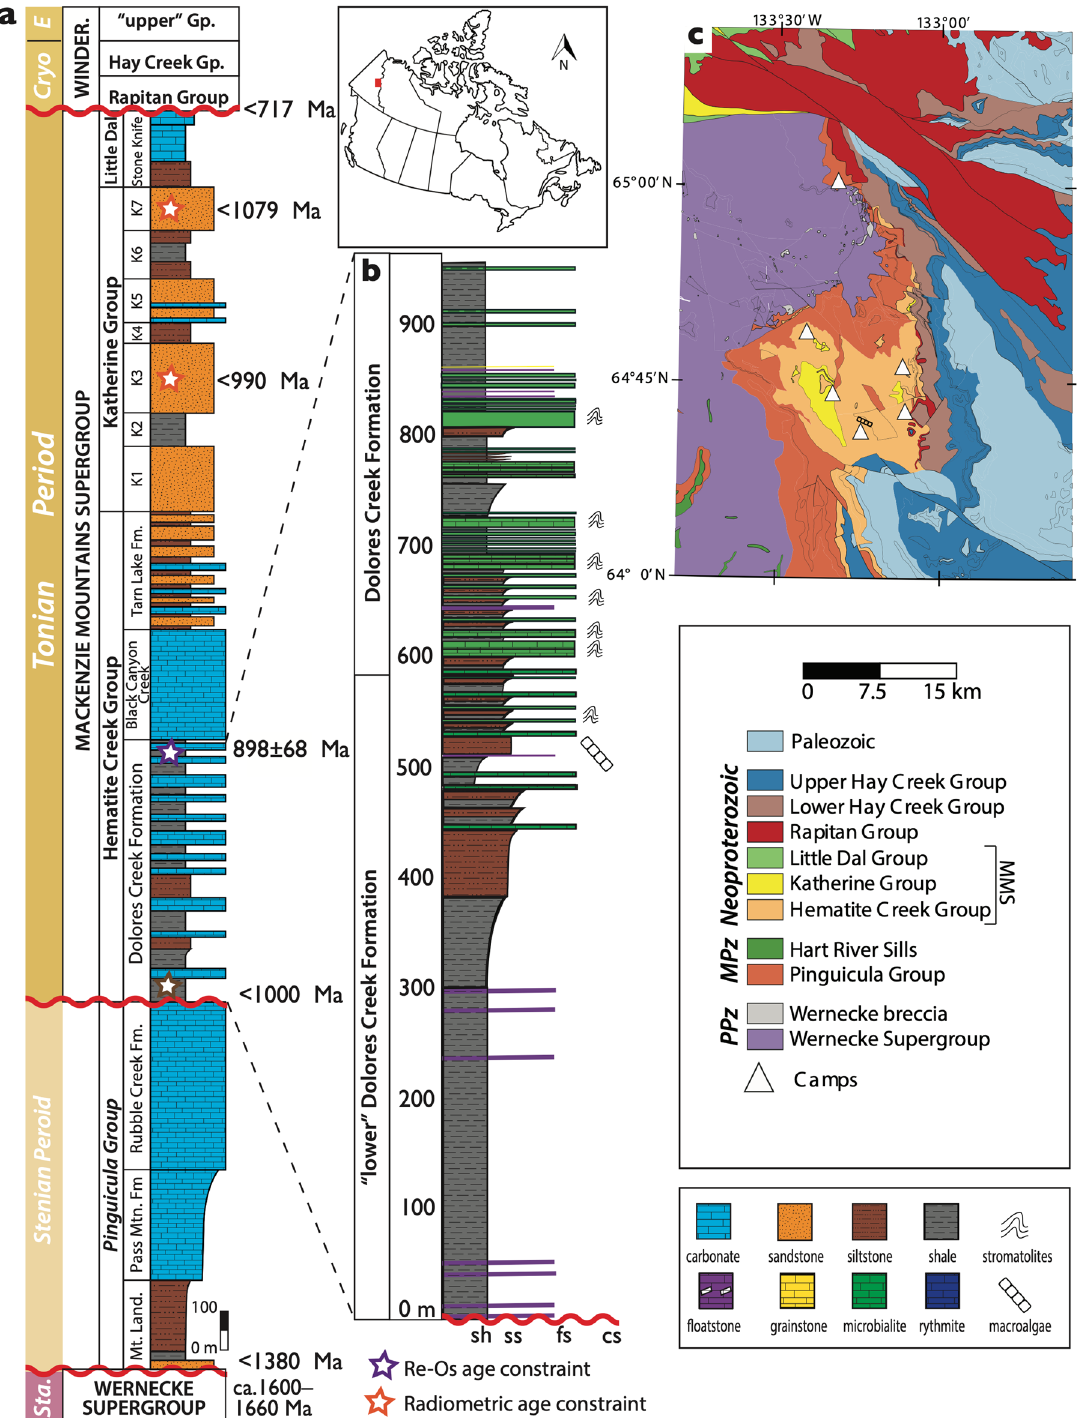
Figure 1. Geologic Setting. ( a ) Stratigraphy log of the Proterozoic strata that outcrop in the Wernecke Mountains with radiometric age constraints. ( b ) Enlarged interval of the fossil section of the Dolores Creek Formation including the informal “lower” Dolores Creek Formation (Yukon, Canada, 64°41 ′ 17.6 ′′ N; 133°14 ′ 30.3 ′′ W). ( c ) Geological map of the Tonian Mackenzie Mountains Supergroup (MMS) in the Wernecke Mountains, showing location of the fossil locality and camps where stratigraphic data was collected. Location of geologic map indicated by the red square on map of Canada. Map is modified from the